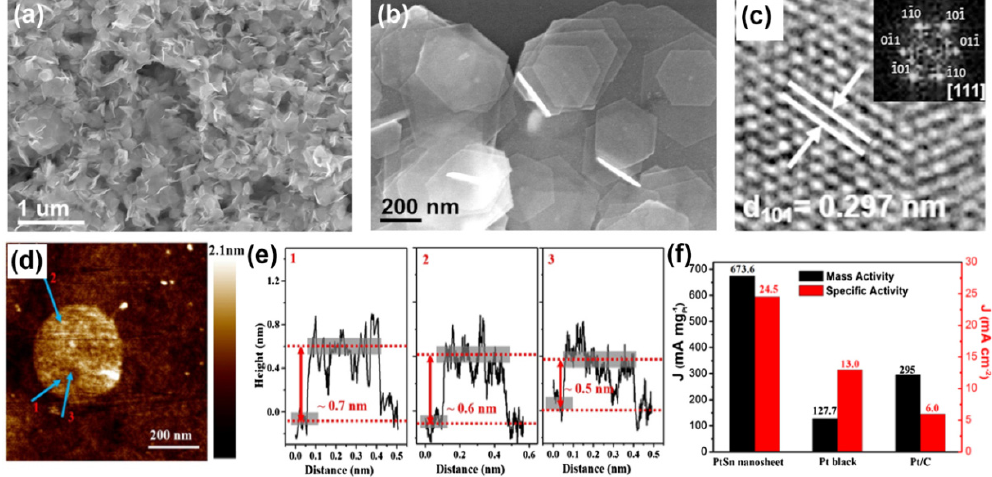
Figure 2. ( a , b ) Scanning electron microscopy (SEM) images and ( c ) high-resolution transmission electron microscopy (TEM) image of PtSn nanosheets, showing a lattice spacing of 0.297 nm. The inset corresponds to the fast Fourier transform image of the same area. ( d , e ) Atomic force microscopy (AFM) image and the thickness of PtSn nanosheets. ( f ) The mass and specific activities (for EOR) of PtSn nanosheet, commercial Pt black and Pt / C. Reproduced with permission from [41]. Copyright 2019, Elsevier Ltd.